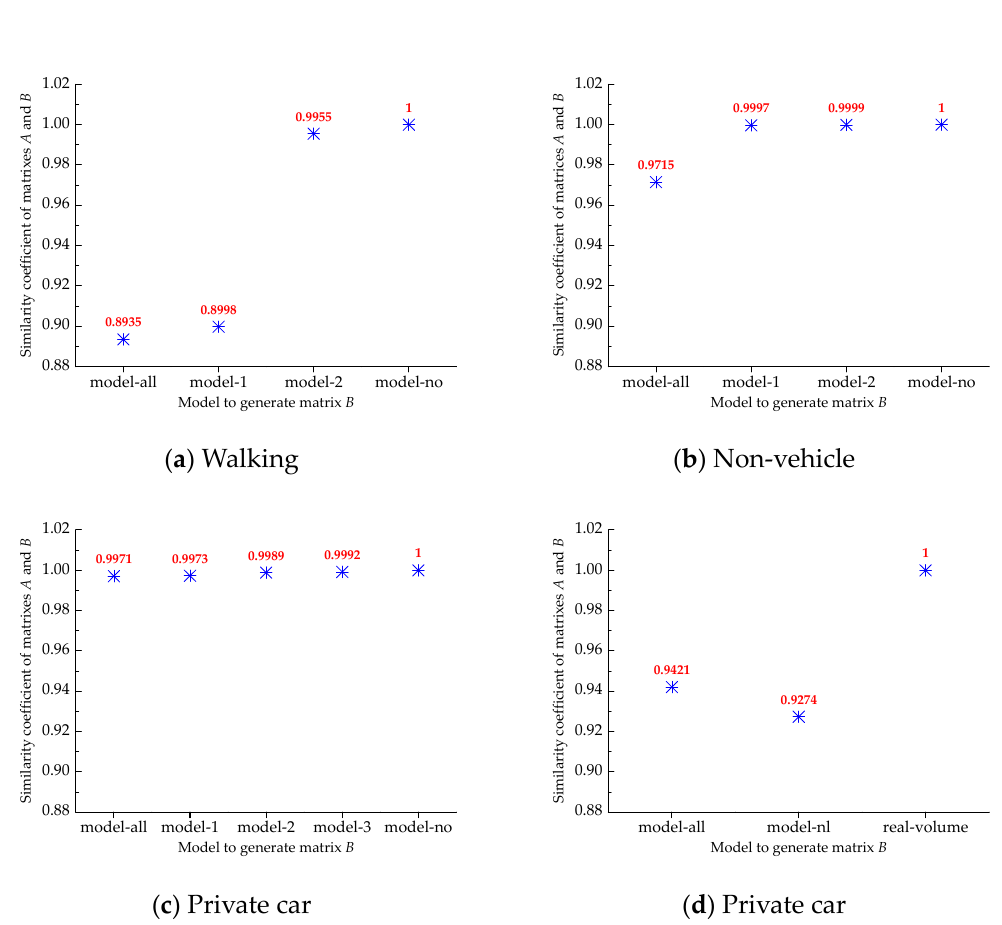
Figure 5. Similarity coefficients between real traffic volume and assignment results for different models.